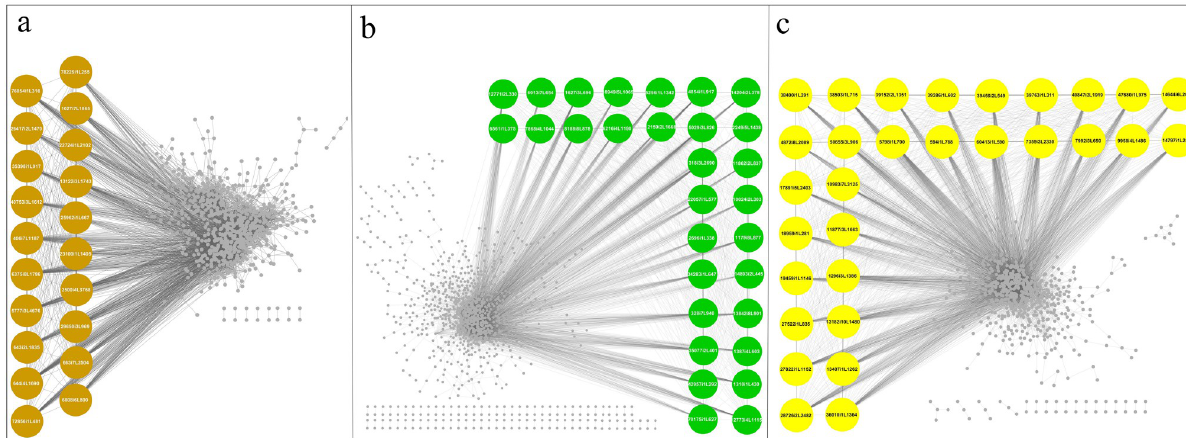
Fig 4. Identification of hub genes involved in metabolite biosynthesis pathway of R . officinalis . Diagrams show the identified hub genes in the brown4 (a), green (b), and yellow (c) modules. Nodes represent genes and brown, green, and yellow bigger nodes indicate the hub genes. The gray line connecting two nodes indicates the correlation between